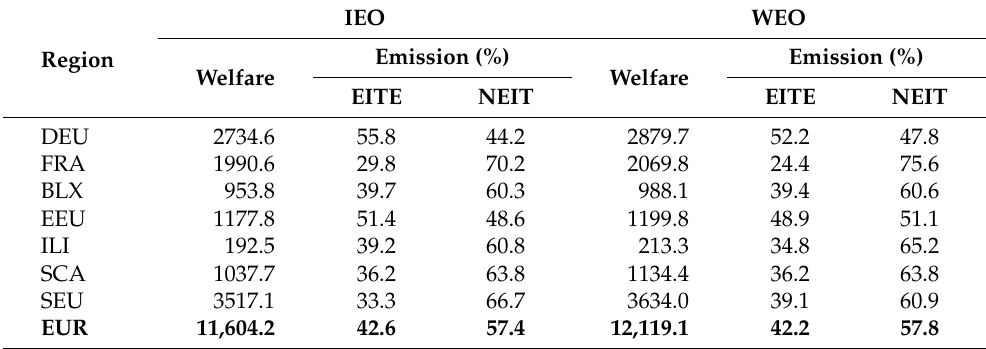
Table 7. Welfare and shares of emissions in the EITE and NEIT sectors in total emissions for the EU for different baselines in 2030.